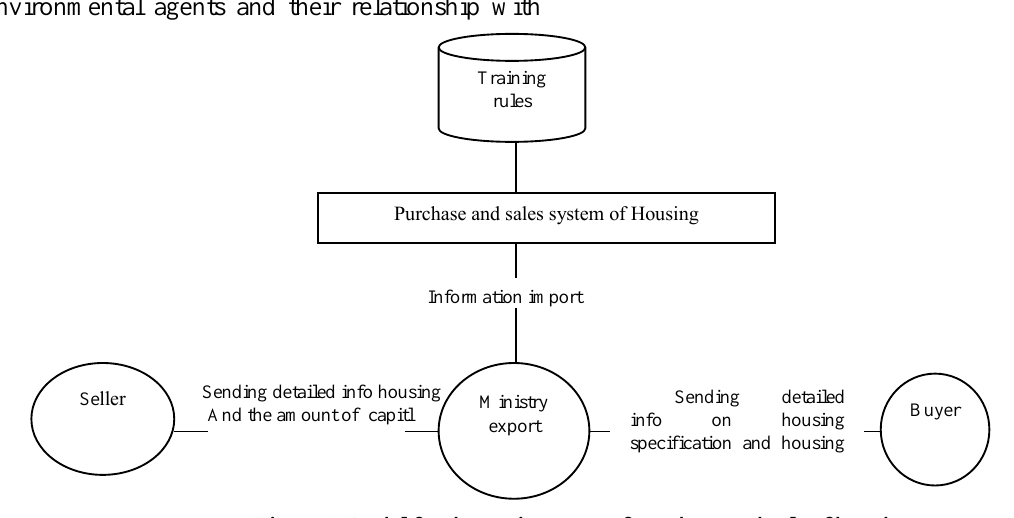
Figure 4. Model for the environment of purchase and sale of